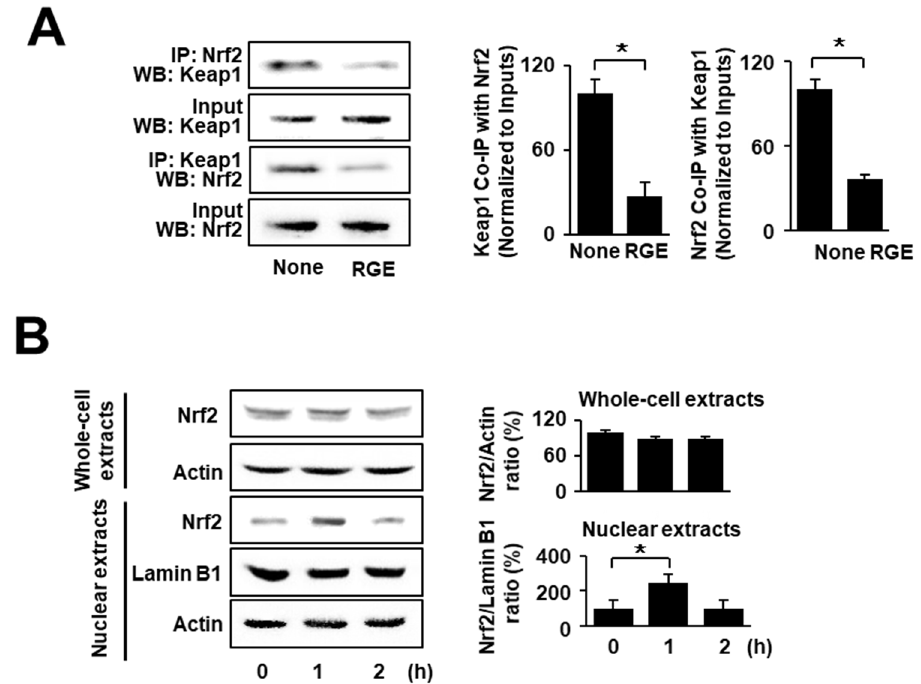
Figure 1. RGE suppresses the interaction of Nrf2 and Keap1 but increases nuclear level of Nrf2 in AGS cells. ( A ) The cells were treated with RGE (1 µ g/mL) for 1 h. Western blots (WB) of whole-cell extracts (Input) and whole-cell extract-derived immunoprecipitates were obtained using the anti-Nrf2 and anti-Keap1 antibodies for immunoprecipitation (IP), and visualized, as indicated. “Input” is used as the control for protein expression (left panel). The ratios of Keap1 Co-IP with Nrf2 and Nrf2 Co-IP with Keap1 were determined from band densities of these proteins. None (cells without RGE treatment) was set at 100. * p < 0.05 (right panel). ( B ) The cells were treated with RGE (1 μ g/mL) for the indicated time periods. The levels of Nrf2 in whole-cell extracts and nuclear extracts were examined by western blotting. Lamin B1 was used as a nuclear marker. Actin was used as a loading control (left panel). The ratios of Nrf2/Actin in whole-cell extracts and Nrf2/Lamin B1 in nuclear extracts were determined from band densities of these proteins. None (cells without RGE treatment) was set at 100. * p < 0.05 (right panel). The densitometry data represent the mean ± standard error (SE) from three immunoblots and are shown as the relative density of protein bands normalized to the indicated protein (input Nrf2, input Keap1, actin, or lamin B1). Co-IP, co-immunoprecipitation.